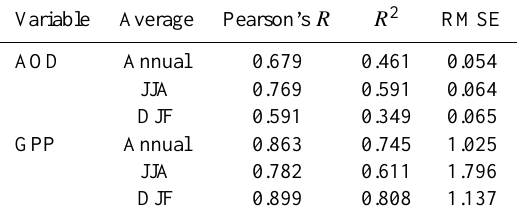
Table 4. Linear correlation Pearson’s coefficient (Pearson’s R ), Pearson’s R squared ( R 2 ), and root-mean-squared error (RMSE) as computed for model evaluation for annual and seasonal average coarse aerosol optical depth (AOD) and gross primary productiv- ity (GPP). Performances of the NASA ModelE2-YIBs in the con- trol present-day simulation ( ∼ 2000s) are compared to (1) MODIS AOD (at 550nm; averaged over 2000–2007) for NASA ModelE2- YIBs PM 10 optical depth and the (2) global FLUXNET-derived GPP product (averaged over 2000–2011). Only boreal summer (JJA) and winter (DJF) seasonal averages are